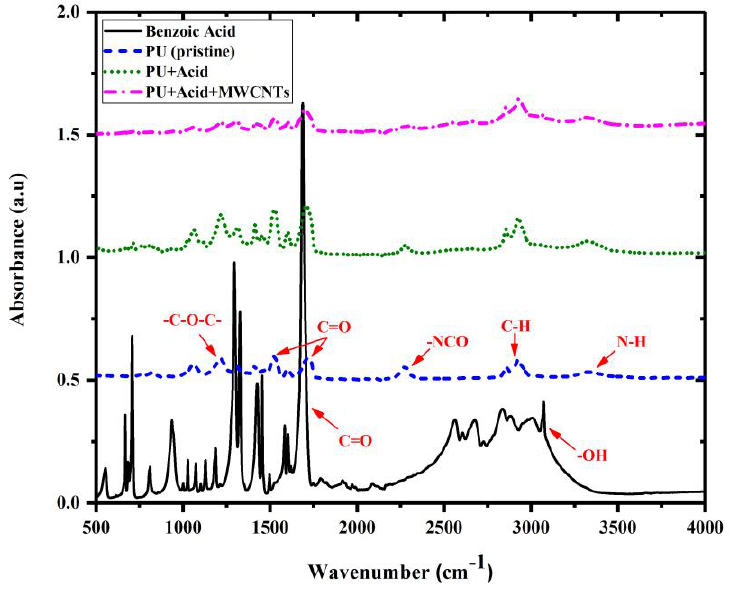
Figure 13. Fourier transform infrared spectroscopy (FTIR) spectrums of benzoic acid and polymer specimens.